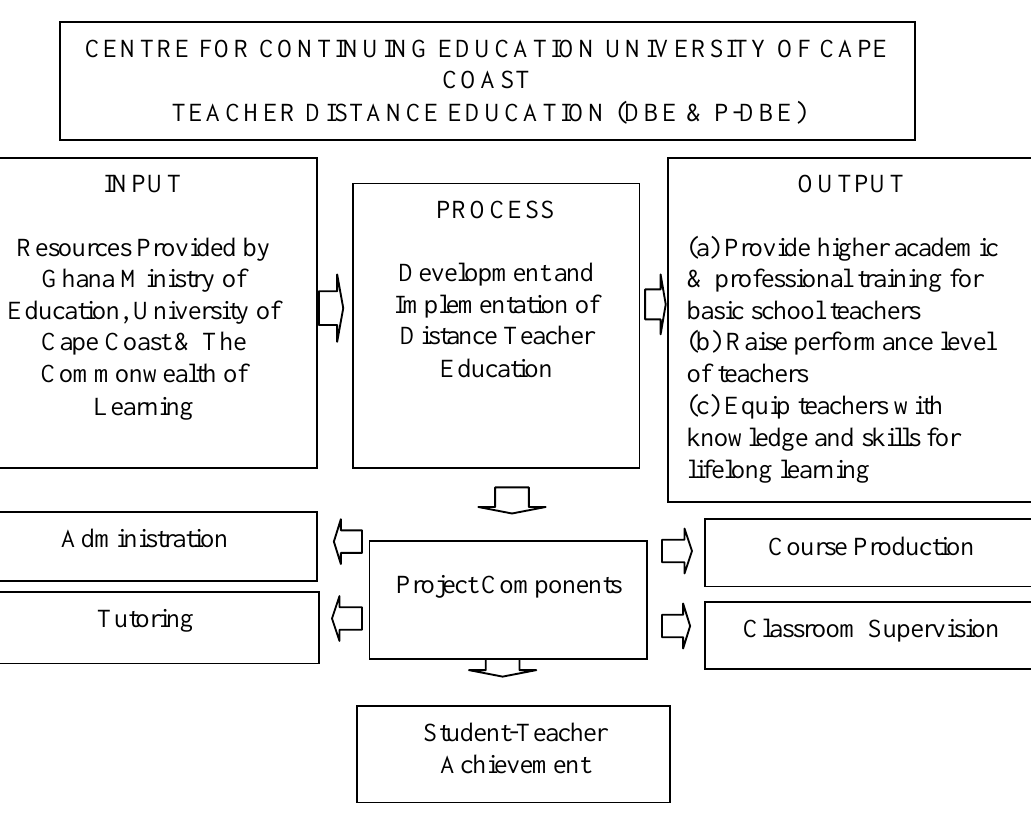
Figure 1 . Program map of the plan of CCEUCC, showing the input, process, and output, as well as the project